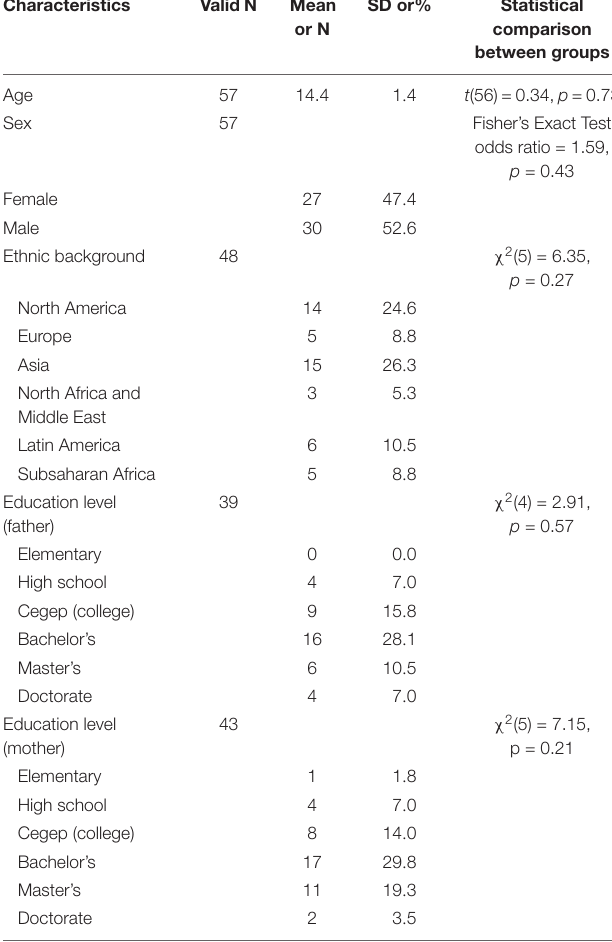
TABLE 1 | Participants’ sociodemographic